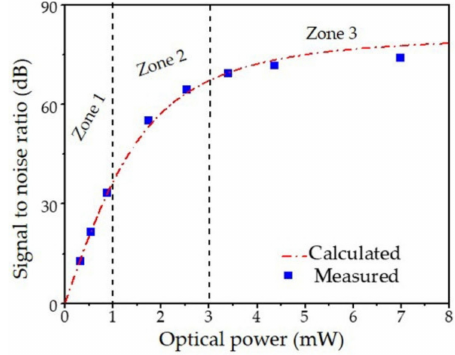
Figure 4. Measured and calculated signal to noise ratio (SNR) at indicated optical power at the